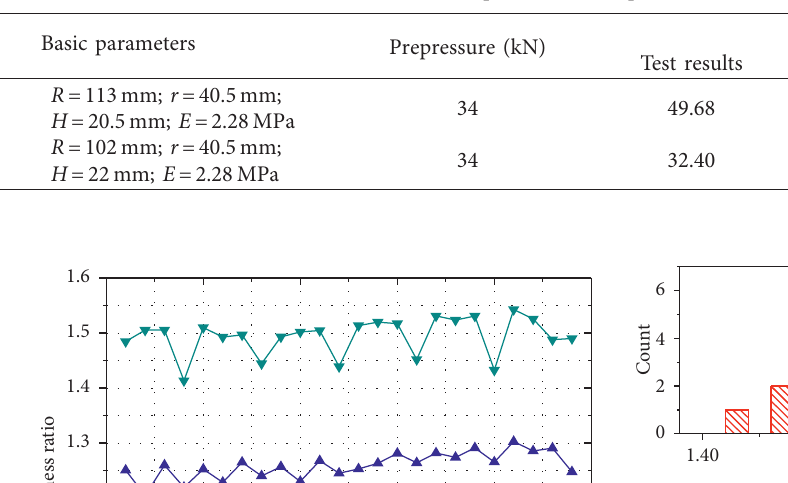
Table 1: Theoretical and experimental comparison of A and B stiffness.